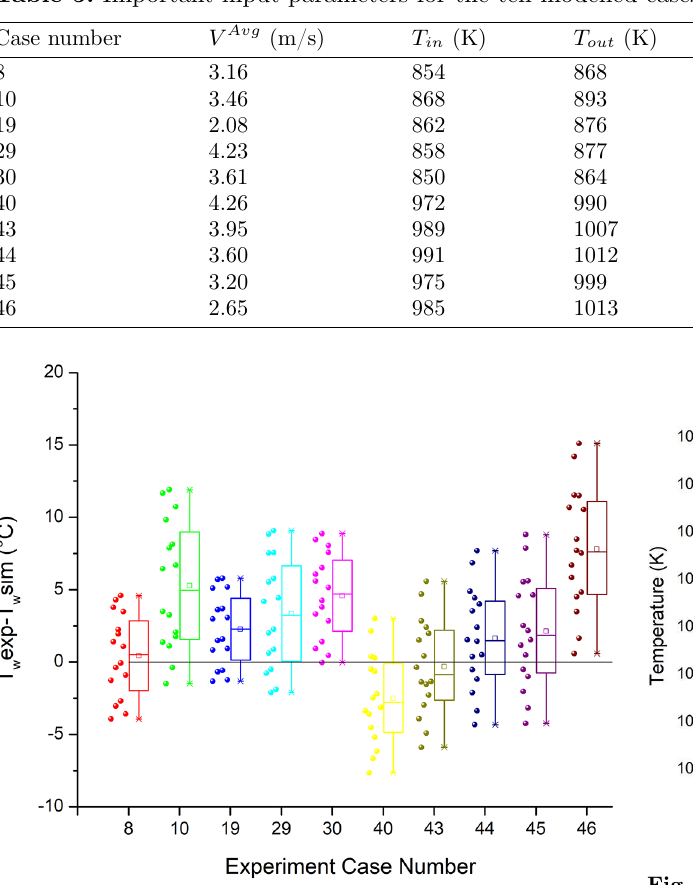
Fig. 5. Difference between the wall temperature measured in the experiment and the wall temperature resulting from the simula- tions for each of the ten cases. The various data points in each case correspond to different selections of material properties of FLiNaK.